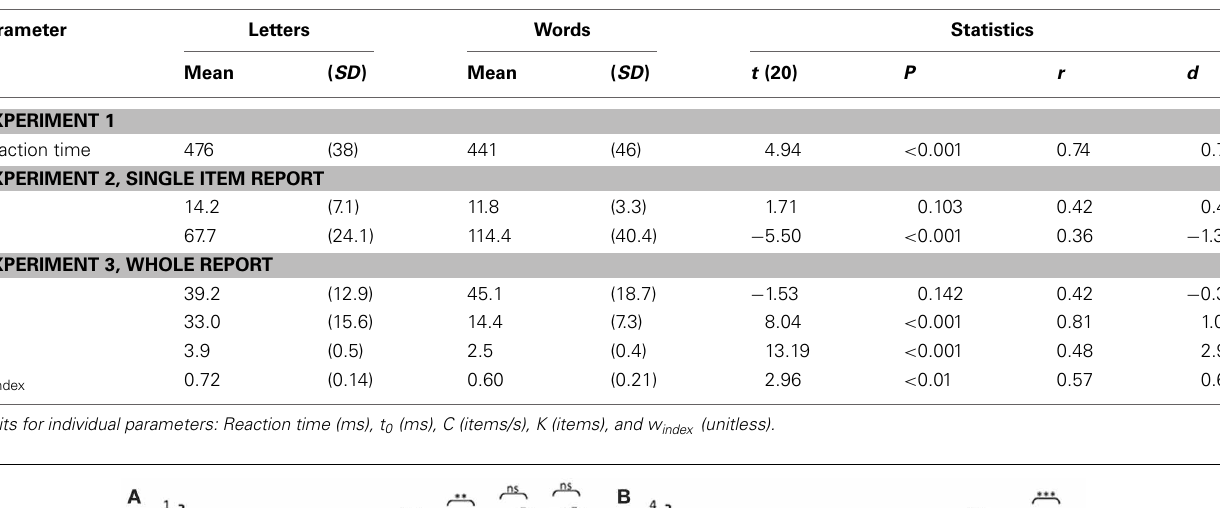
Table 1 | Performance and statistics across conditions for Experiments 1–3.